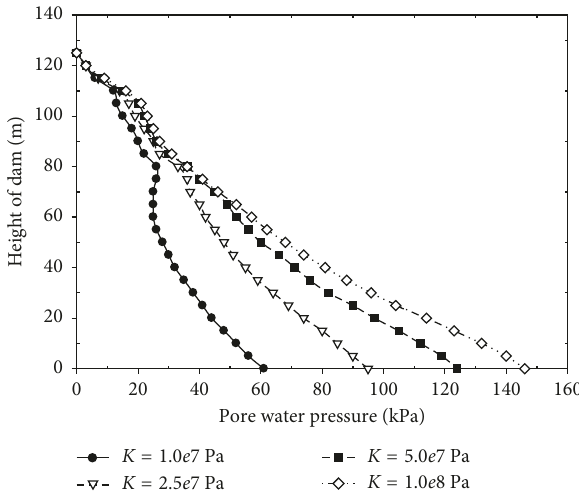
Figure 9: Comparing the pore water pressure values for different bulk modulus of water.